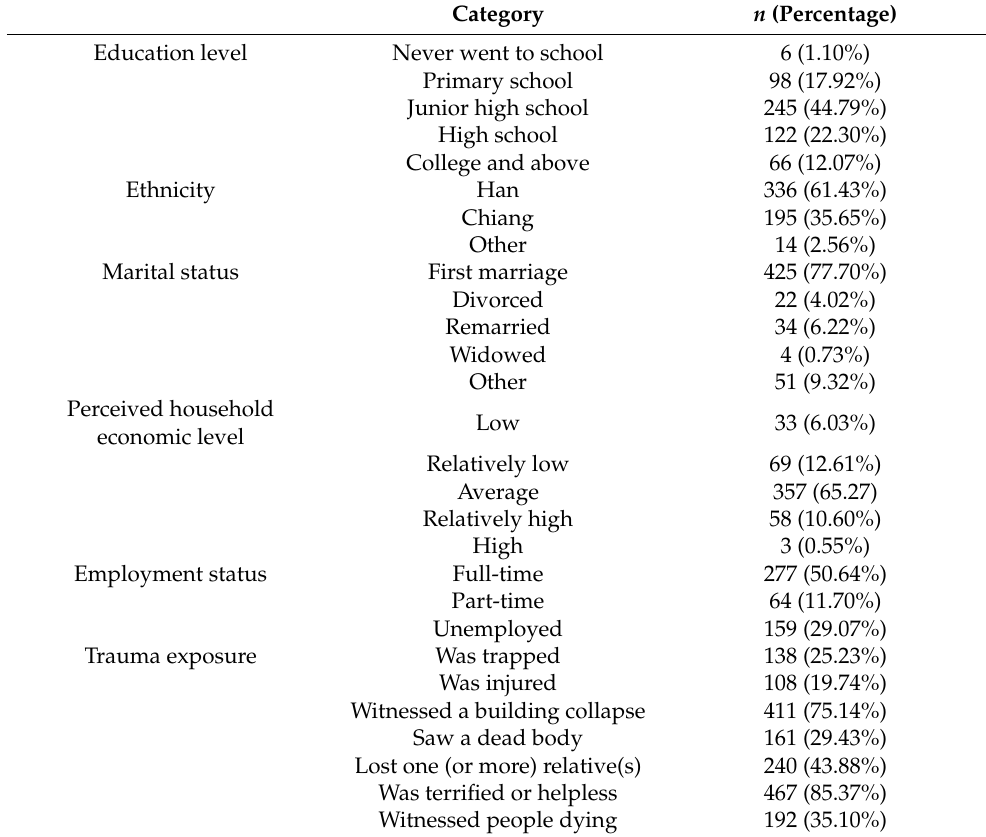
Table 1. Mothers’ demographic and trauma exposure information ( n =